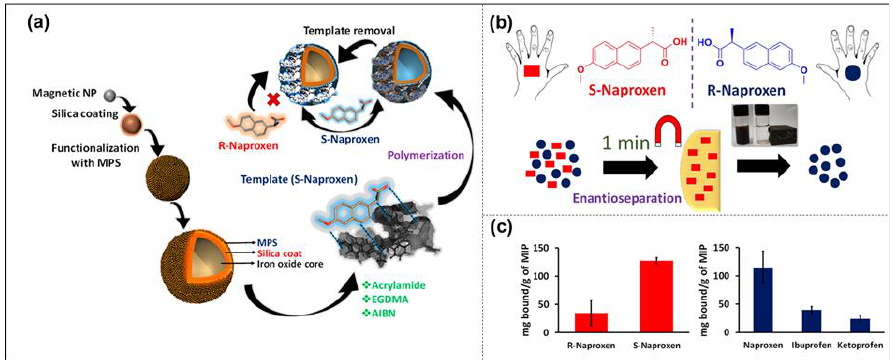
Figure 2. The overview of the synthesis of (S)-naproxen-imprinted nanoparticles ( a ); rapid magnetic separation of enantiomers ( b ); selective nature towards enantiomer, (R)-naproxen, and other similar structures, ibuprofen and ketoprofen ( c ) Reprinted with permission from Ref. [41]. Copyright 2019, ACS.